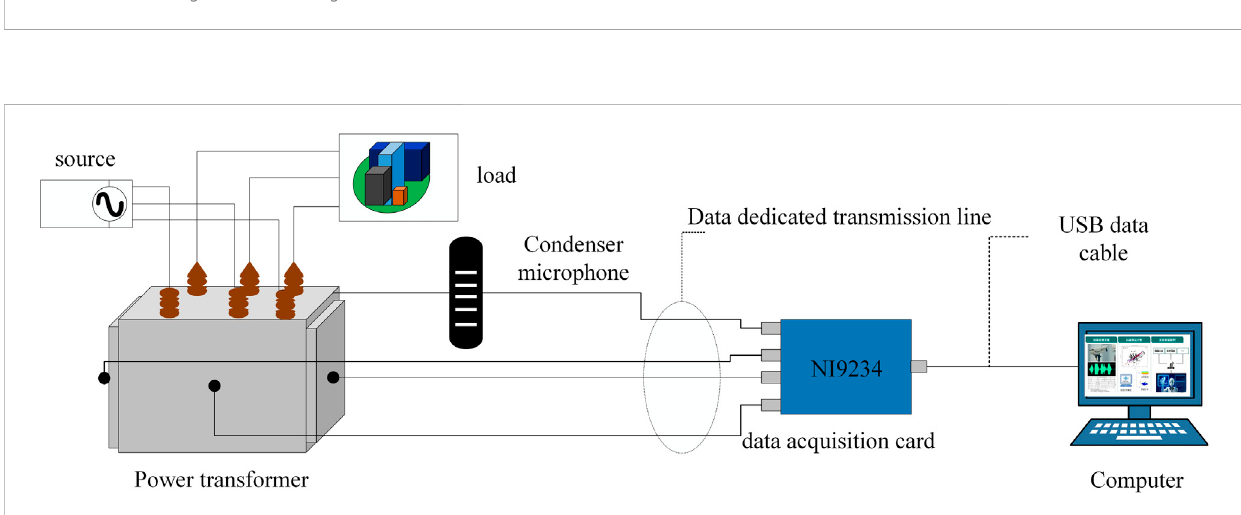
FIGURE 13 Transformer winding short circuit diagnosis model of WKPCA-WM and IPOA-CNN.